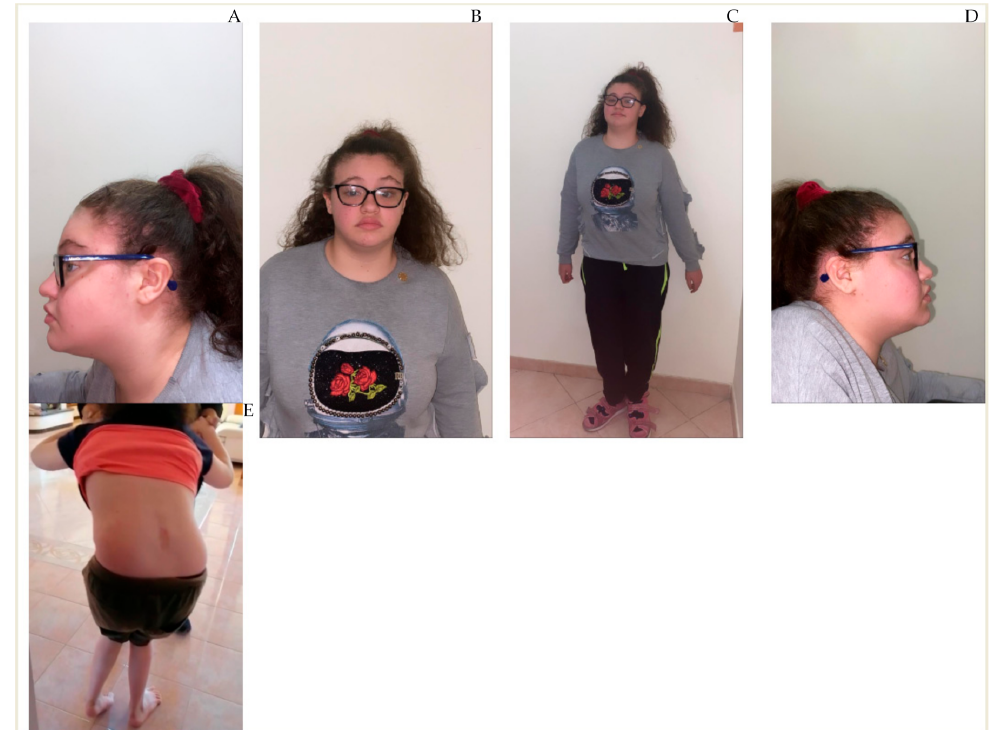
Figure 1. Phenotypic features and neurologic findings of the patient. Distinctive findings: Curly hair ( A , B ), coarse face with thickened eyebrows ( B ), ptosis ( B , C ), epicanthal folds ( B ), bulbous nose ( B ), flashy lips ( B ), everted upper lip ( B ), thickened helix ( A ), small low-set ears ( A–D ), short neck ( D ). Roto-scoliotic left curve at lumbar segment with right hip elevation ( E ). Lower limbs muscle hypotrophy and foot deformities (pes equinovarus) ( E